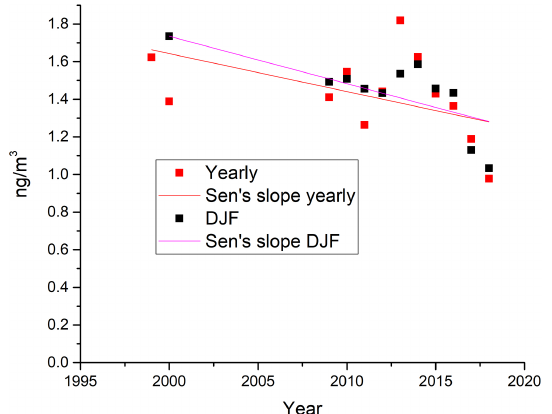
Figure 5. Yearly (orange) and winter season (December, January and February – DJF; blue) average values of measured GEM con- centrations at Villum, with trend